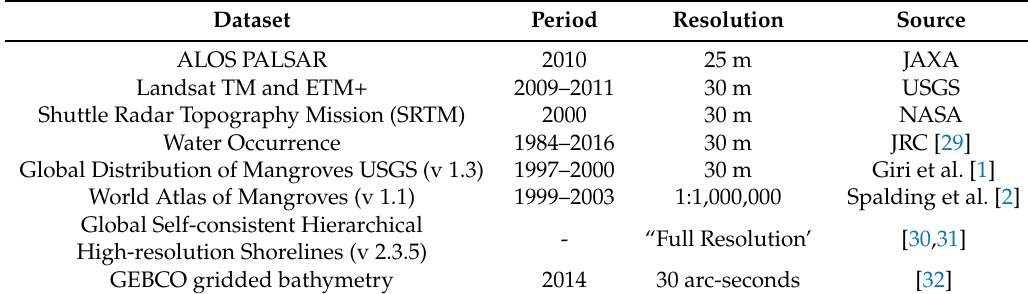
All data were re-sampled or rasterised onto the same 0.8 arc-second pixel grid as the ALOS PALSAR data. For the SRTM data cubic spline interpolation was used, while for other continuous data (e.g., Landsat) a cubic convolution was applied and for categorical data nearest neighbour interpolation was